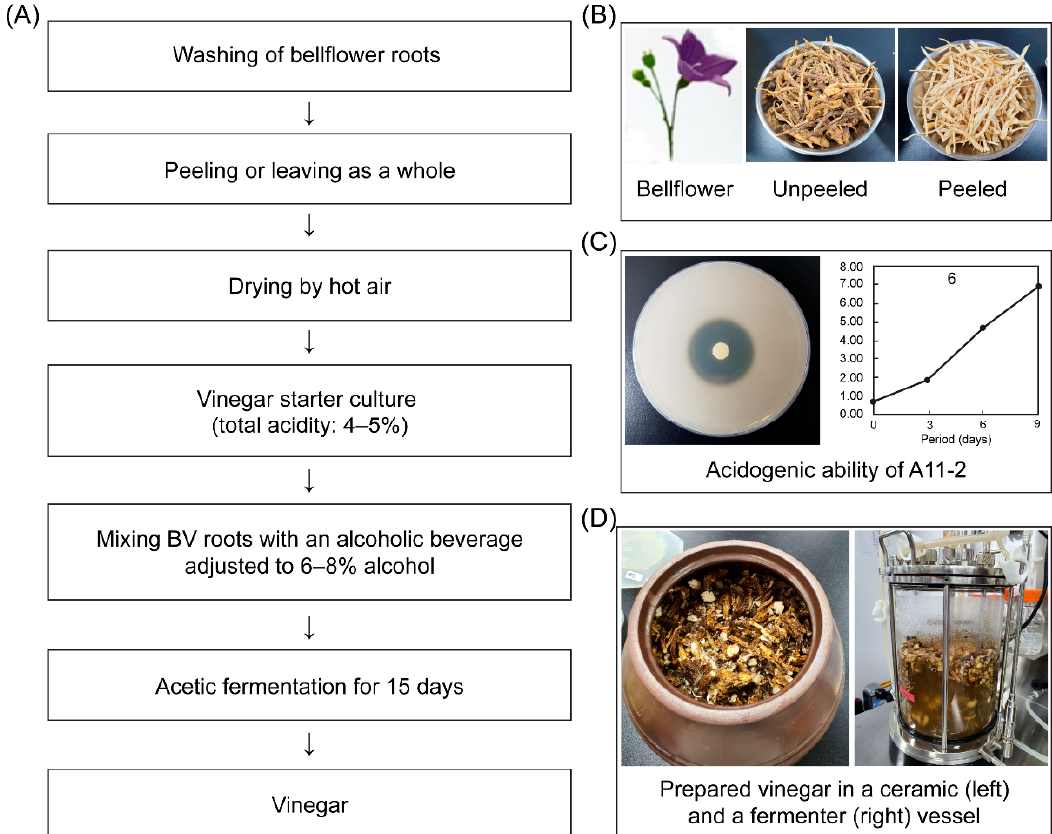
Figure 1. Flow chart of vinegar manufacturing using peeled and unpeeled bellflower roots. ( A ) Processing of bellflower vinegar (BV). ( B ) Raw material of bellflower. ( C ) Acidogenic ability of Acetobacter pasteurianus A11-2 as a starter culture. ( D ) Fermented vessels (traditional ceramic and fermenter) used for vinegar fermentation.